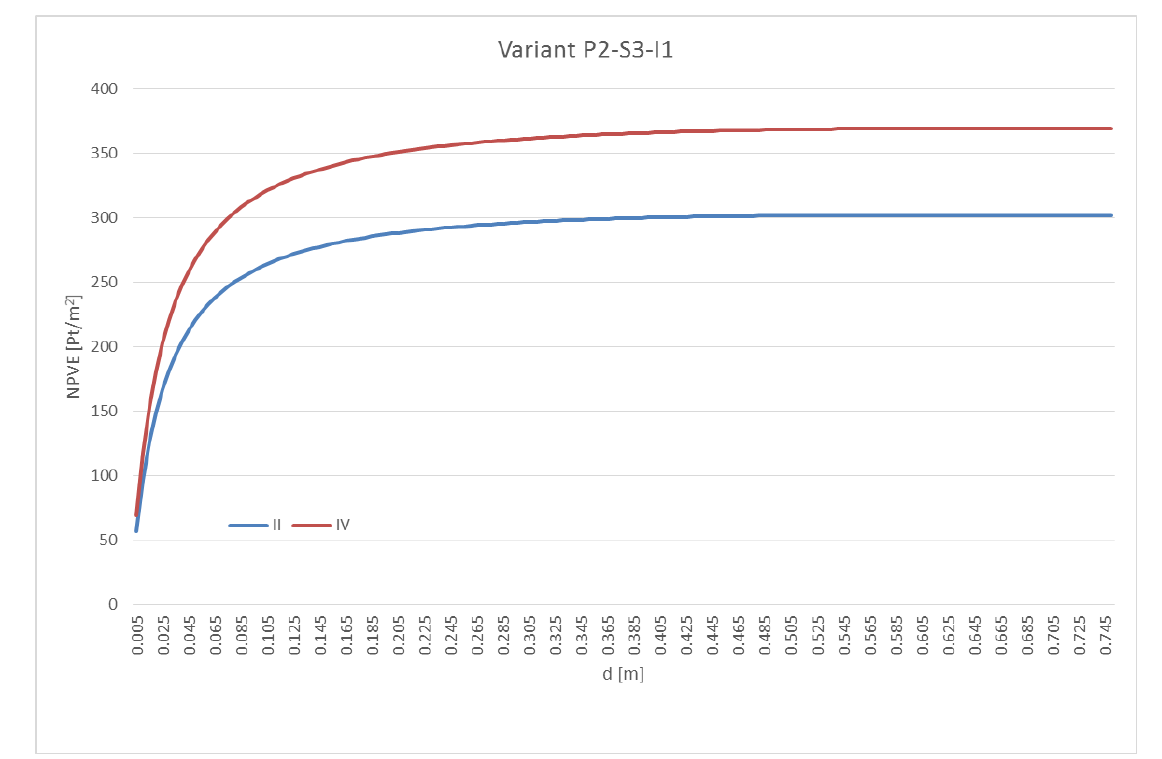
Figure 7. NPV E values depending on the thickness of thermal insulation for variant P2-S3-I1 in zones II and IV.